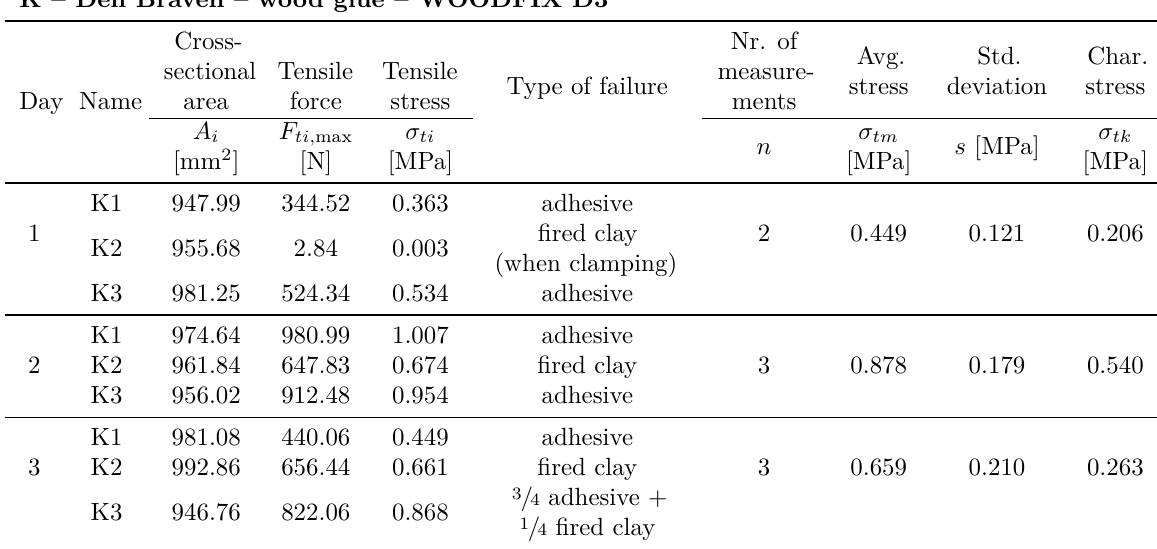
Table 2. The values and the information obtained from the adhesion test [1].